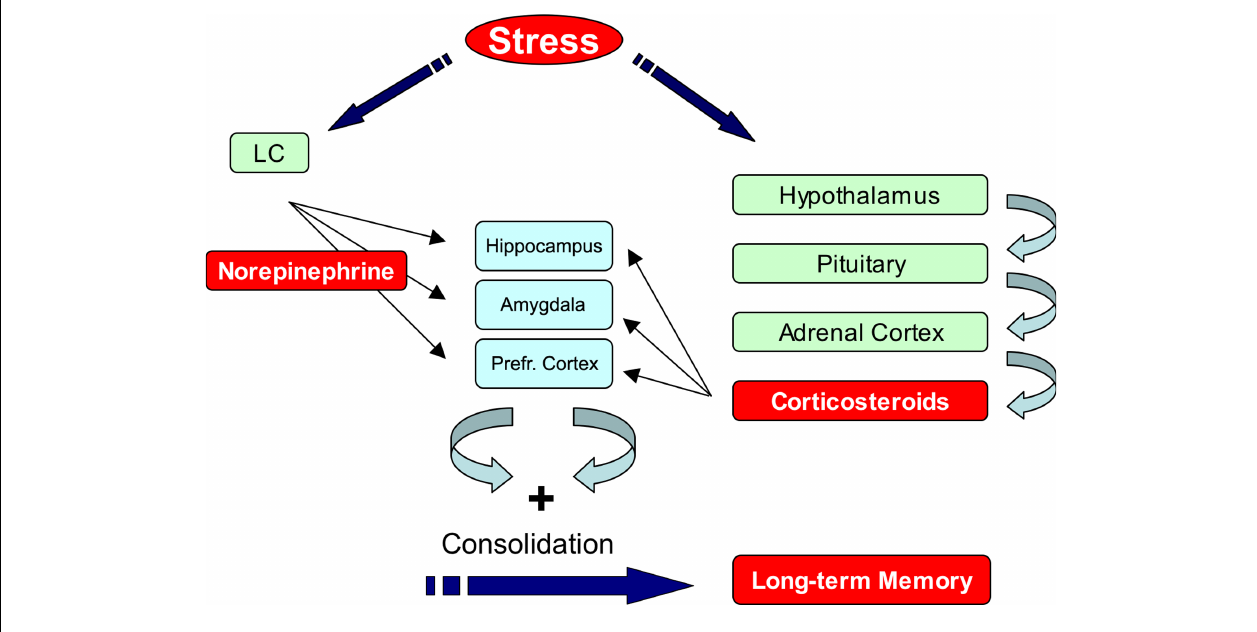
corticosterone levels. These hormones act via their receptors, which are present in regions that are critical for memory formation such as hippocampus, amygdala, and prefrontal cortex, to promote memory consolidation. For details see text. LC: Locus Coeruleus, Prefr. Cortex: Prefrontal